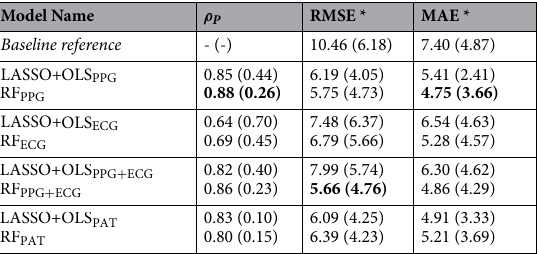
Table 5. Performance statistics of (cid:31) SBP estimation using the models proposed. Results are given as median (IQR) computed across all folds of the LOSOCV. Entries in bold indicate the best performance for that metric. * results given in units of mmHg.